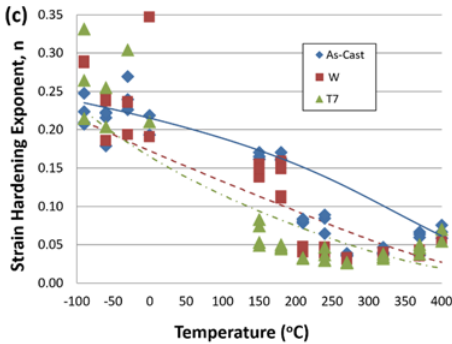
Figure 6. Temperature ‐ dependence of ( a ) strength coefficient ( K ); ( b ) ductility parameter ( A ); and ( c ) strain hardening exponent ( n ), for Al ‐ A319 alloys in various heat treatment conditions. Symbols represent experimental data and the curves are the prediction of the model, respectively.